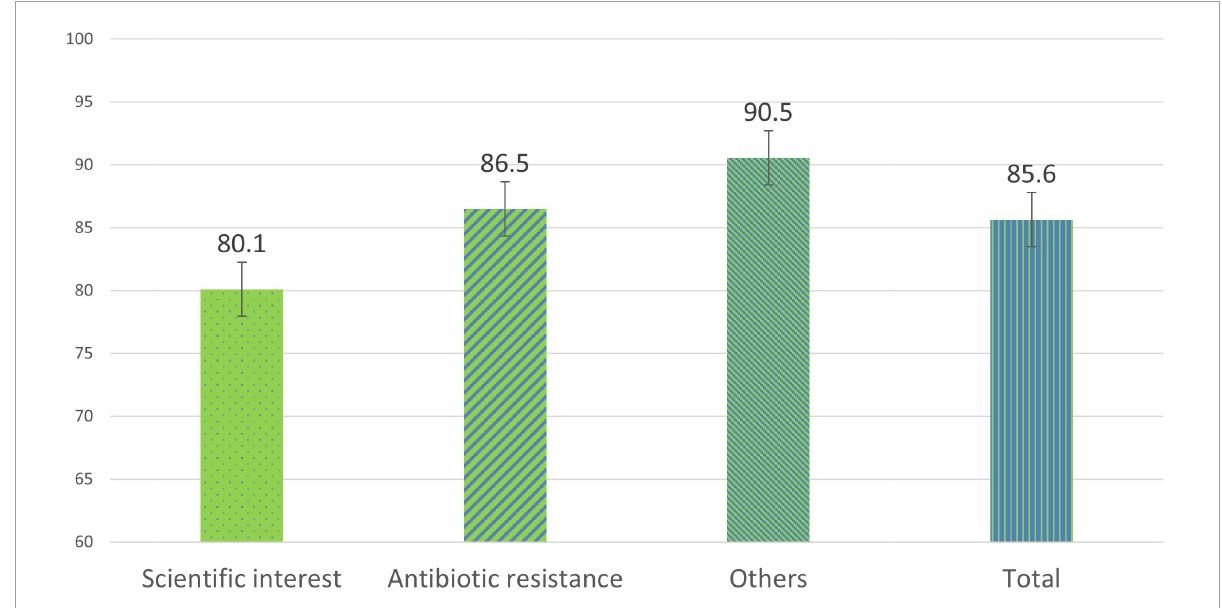
FIGURE2 Percentages of the average satisfaction values of each general section in pre-university students at the end of the SWICEU project during the 2017–2021 academic years.